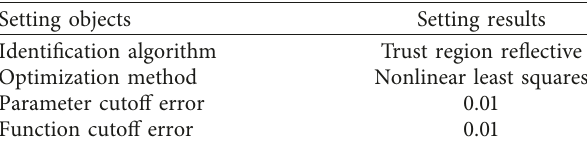
Figure 5: Nonlinear mechanical model of the hydraulic electric inerter.